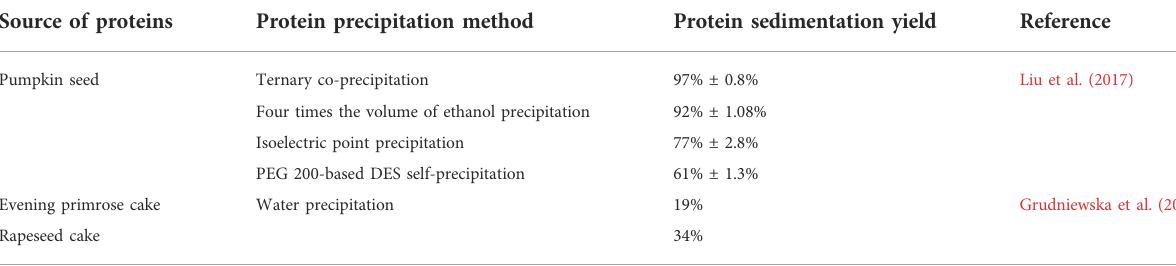
TABLE 4 Methods used for protein precipitation in DESs using various protein